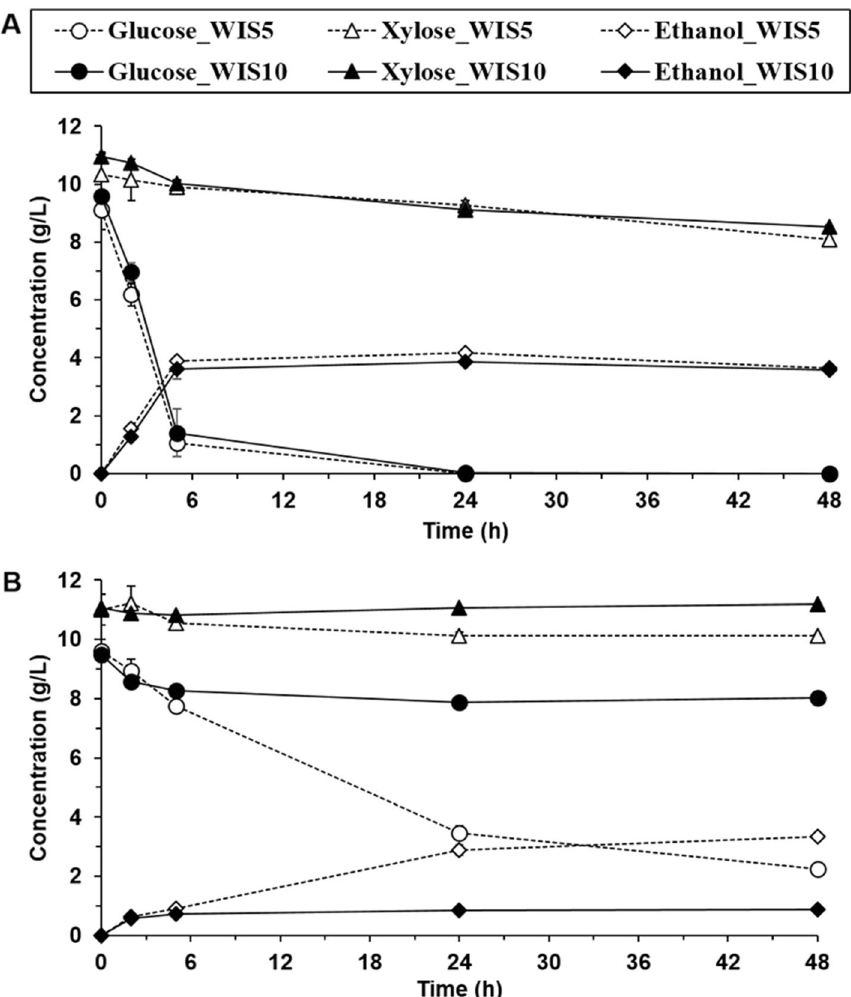
Figure 2. Fermentation assays with ( A ) 50% and ( B ) 100% (v/v) inhibitor mix in presence of 5% and 10% (w/w)